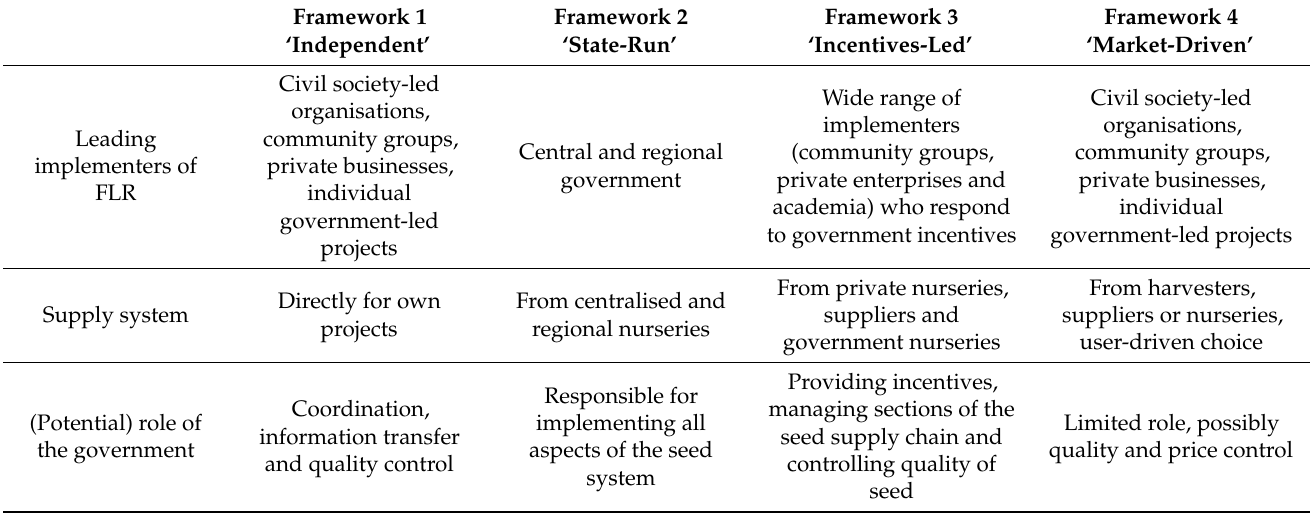
Table 2. Overview of key features of the four frameworks for a tree see system adapted from Atkinson et al. [26].